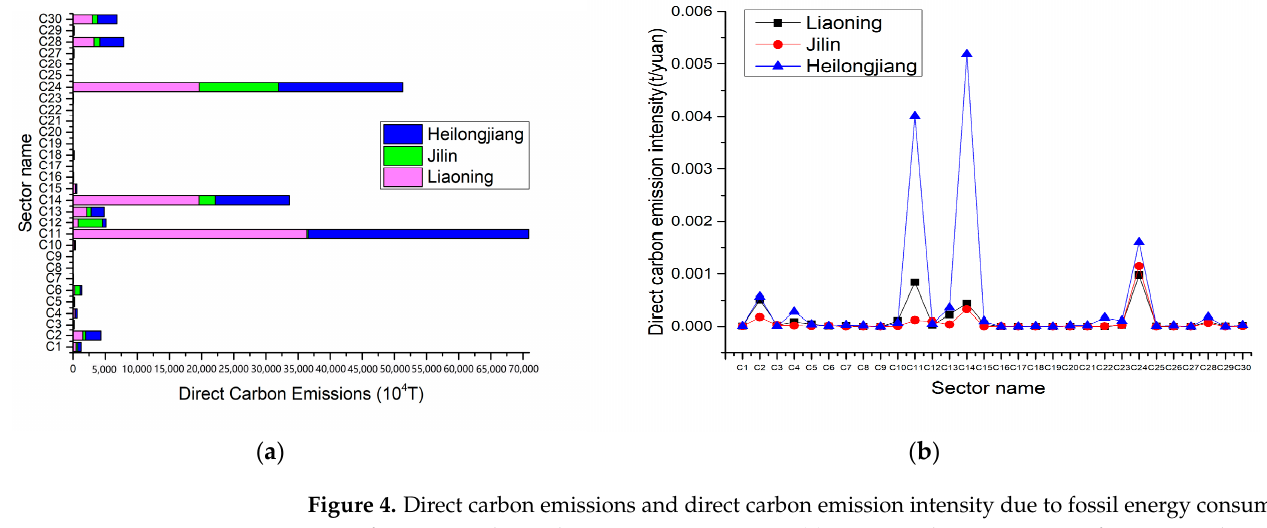
Figure 4. Direct carbon emissions and direct carbon emission intensity due to fossil energy con- sumption of various industrial sectors in Hei-Ji-Liao. ( a ) Direct carbon emissions of various indus- trial sectors in Hei-Ji-Liao. ( b ) Direct carbon emission intensity of various industrial sectors in Hei-